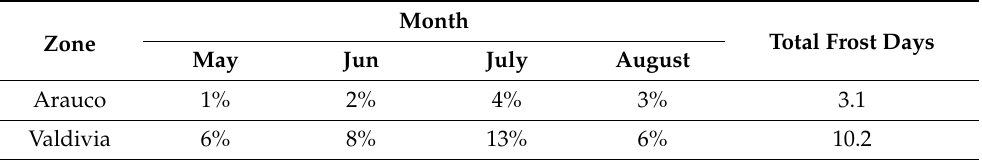
Table 1. Average of a 30-year period of observations of the proportion of days under 0 ◦ C degrees in Arauco and Valdivia zones for the months from May to August. Total frost days are estimated based on the proportion of days under 0 ◦ C and the number of days of each month from May to August.